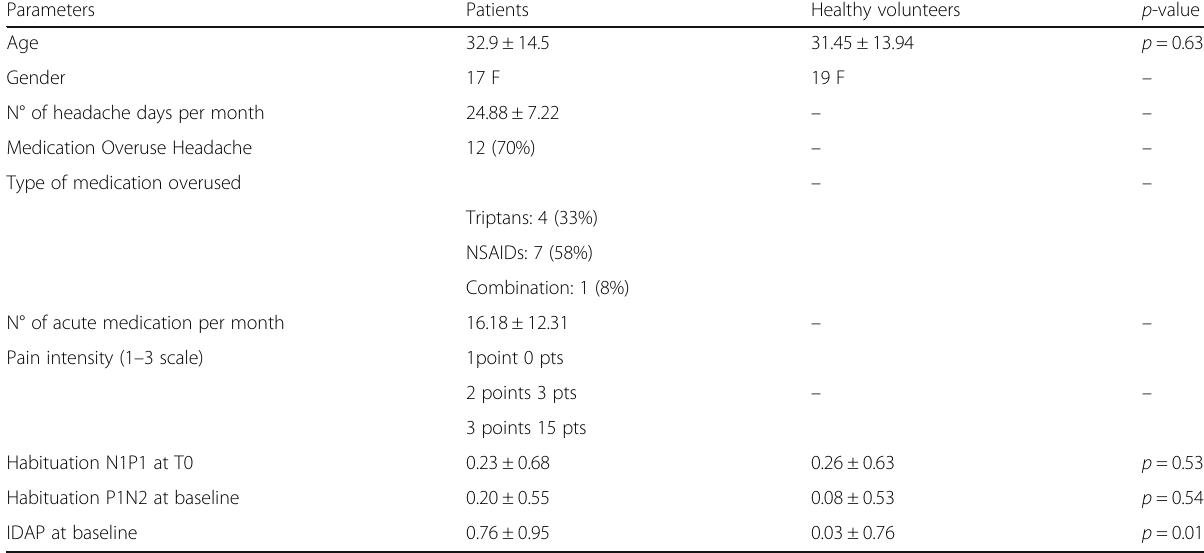
Table 1 Baseline characteristics of CM patients Parameters